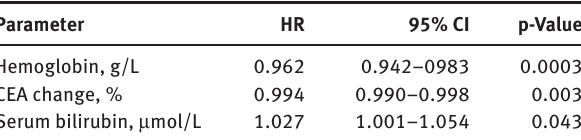
Table 5: Multivariate analysis of the prognostic significance of clinical and laboratory